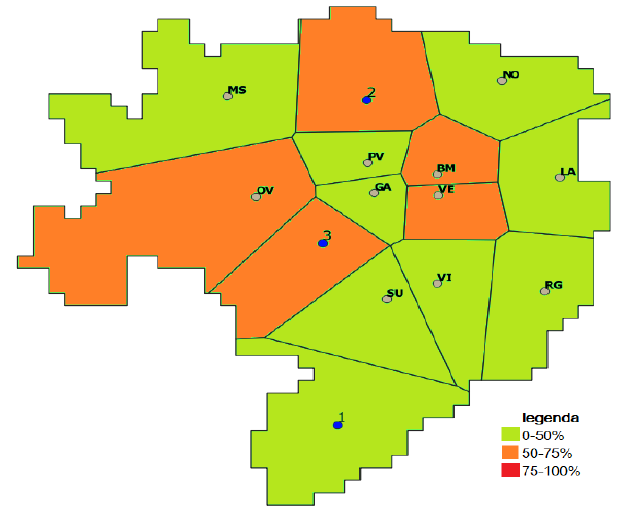
Figure 20. PS service areas of three incremental PSs. The colors show the loading of the PS trans-